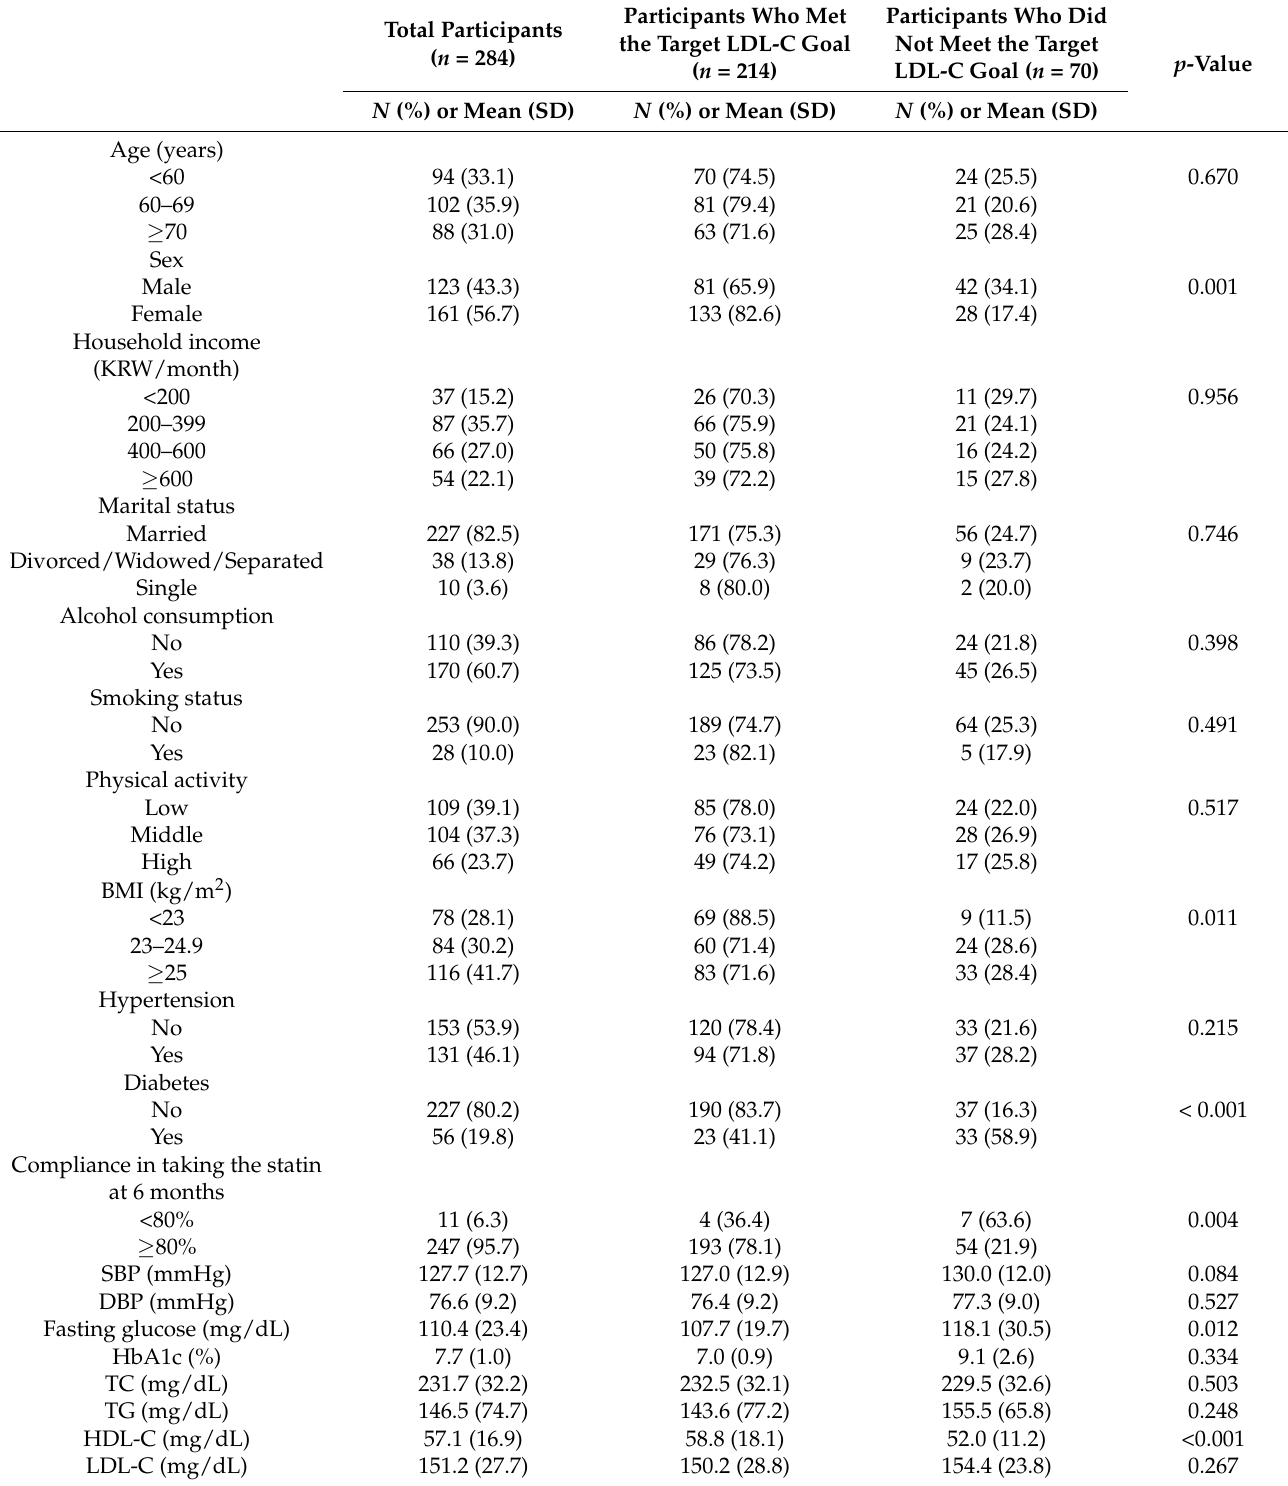
Table 1. Baseline characteristics of the 284 study participants with and without controlled low-density lipoprotein cholesterol (LDL-C) at 6